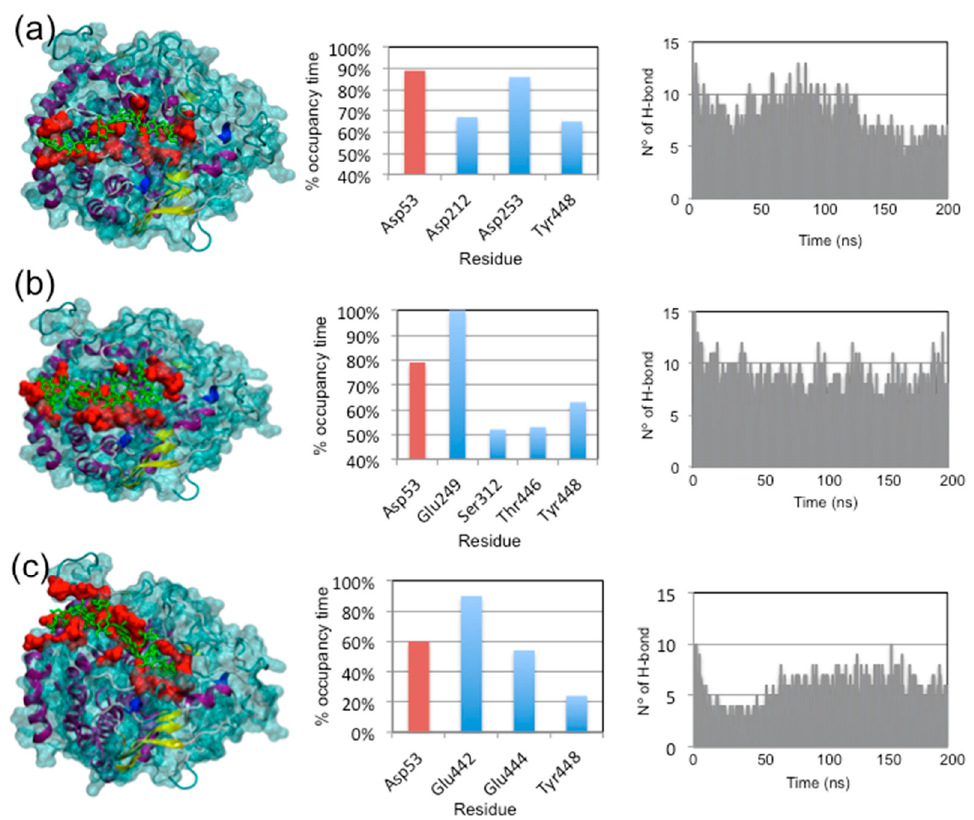
Figure 5. MDS analyses of the interaction of FaEG1 with cellulose ( a ) and two hemicellulose octasaccharides: XXXGXXXG ( b ) and XXFGXXFG ( c ). In the left, a general view of the interaction of the protein and the corresponding ligand. In the center, a graph indicating the percentage of time that a hydrogen bond between particular amino acid residues and the ligand is established; the catalytic residues are shown in red. On the right are the number of hydrogen bonds established during MDS between the ligand and di ff erent amino acid residues located in the open groove of each protein model. Only values greater than or equal to 40% frequency are shown in the center graph to ( a ) and ( b ) graphics, while the values greater than or equal to 10% frequency are shown in the ( c ) center graph.